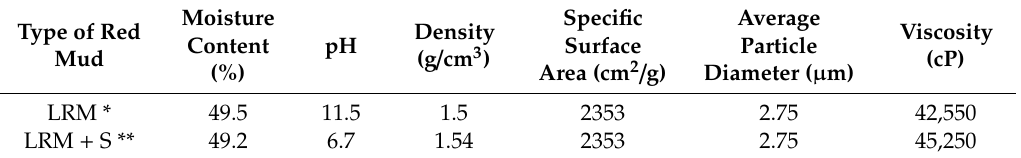
Table 1. Physical properties of red mud.